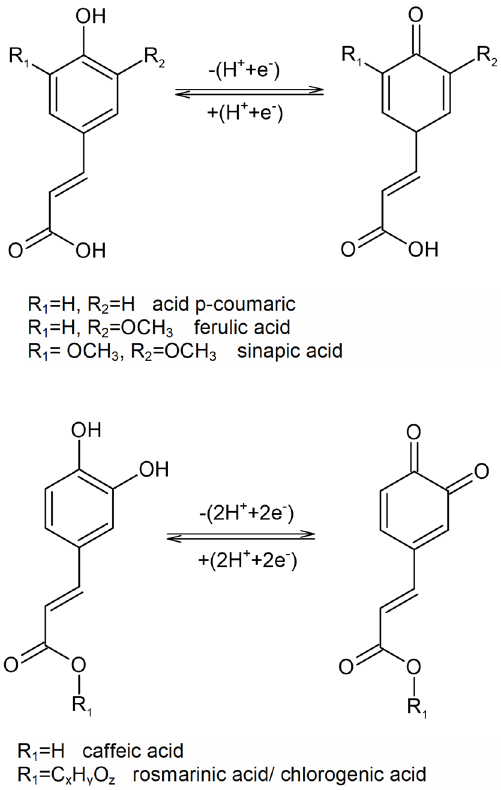
Figure 3. The redox processes of HCs at the sensitive element of the biosensors based on tyrosinase or laccase.